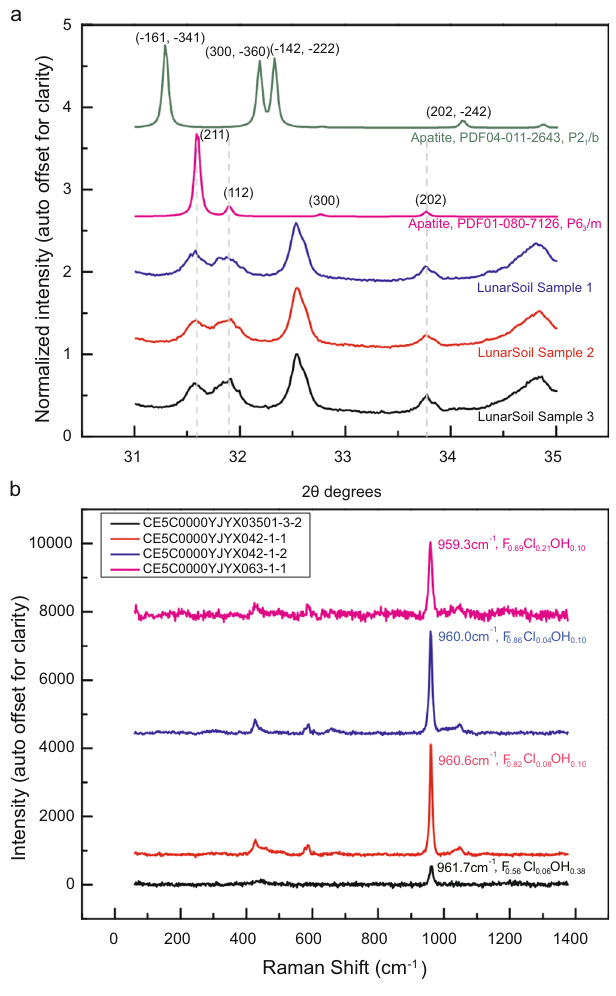
Fig. 3 The X-ray diffraction (XRD) measurements of Chang ’ E-5 lunar soil samples and Raman spectra analysis of Chang ’ E-5 apatite grains in the polished sections. a Identi fi cation of apatite in lunar soil samples by matching XRD features with the mineral powder diffraction fi les (PDF) of the International Center for Diffraction Data (ICDD). There are two kinds of crystal structures in apatite: P6 3 /m and P2 1 /b, and the crystal structure of apatite identi fi ed in the lunar soils is P6 3 /m. The gray dashed lines show the diffraction peaks of lunar soils matching result with the standard apatite mineral features of the three crystal planes (211), (112), and (202), and the diffraction pattern of the standard apatite mineral (PDF01-080-7126) has been (h00) preferred orientation corrected. b The Raman spectra of different apatite grains in the polished sections. The apatite formulas shown in the fi gure is derived from the corresponding electron-probe micro- analysis (EPMA) results. We infer that the Raman peak shifts toward 962 cm − 1 as the proportion of OH in the apatite grains increased. Part of the Raman measurement positions are marked in Fig.